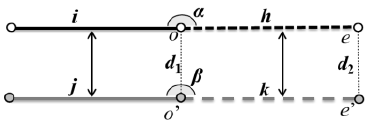
Figure 2. Compatibility calculation between two neighbouring matching pairs